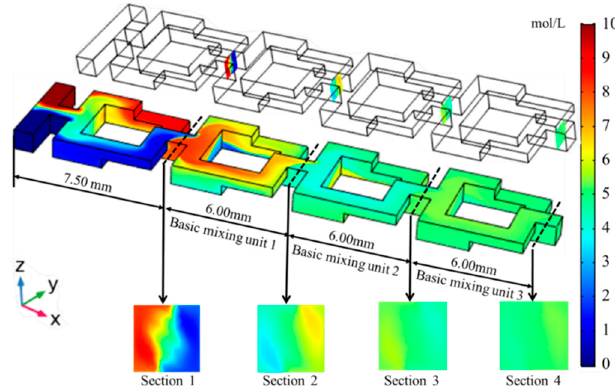
Figure 6. Concentration distribution nephogram of chaotic Baker pipeline flow path under U 0 = 0.05 m/s and D 0 = 5 × 10 − 10 m 2 /s and schematic diagram of four cross-section intercept- ing locations on the flow pipeline.